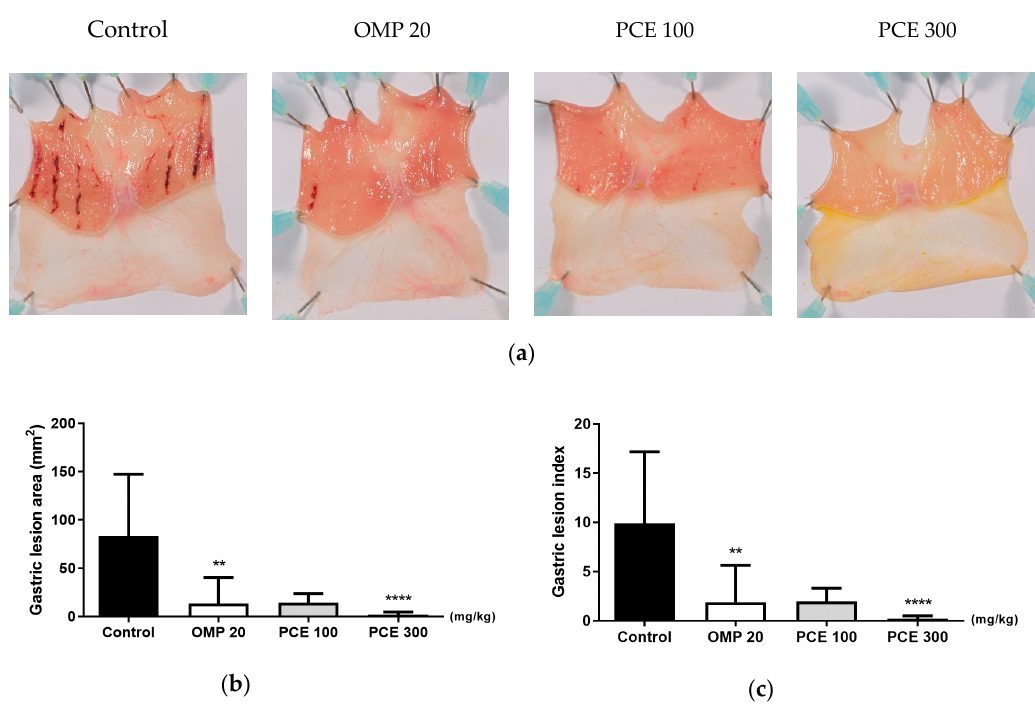
Figure 2. Effects of PCE on hydrochloric acid/ethanol (HCl/EtOH)-induced rat gastric mucosal injury. ( a ) Representative macroscopic images of stomachs from each group. One hour prior to HCl/EtOH administration, rats were orally treated with distilled water (control), OMP 20 mg/kg, PCE 100 mg/kg, or PCE 300 mg/kg. Measurement of gastric lesion area ( b ) and gastric lesion index ( c ). Values are expressed as mean ± standard deviation. n = 7–8 per group. ** p < 0.01 and **** p < 0.0001 vs. control by Kruskal–Wallis test with Dunn’s multiple comparisons test. OMP, omeprazole; PCE, P. cuspidatum extract.